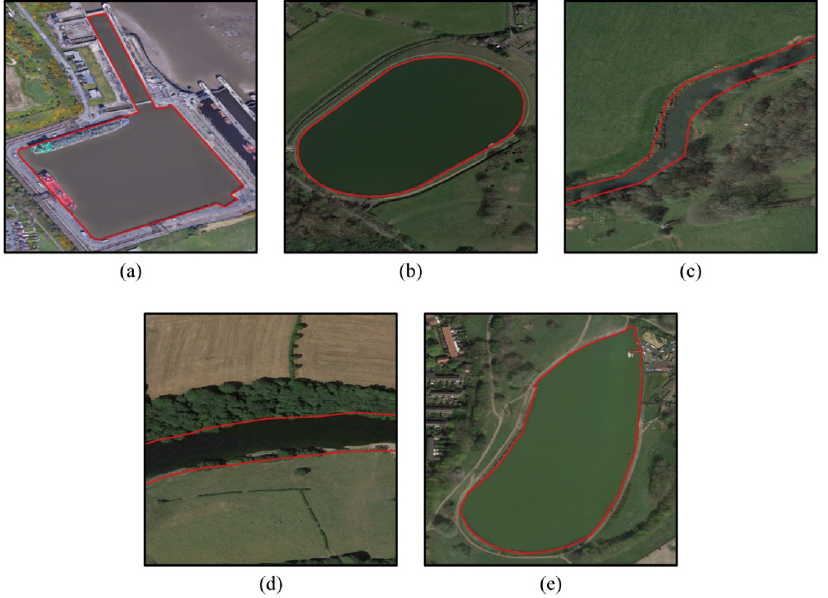
Figure 7. Overlapping Google Earth images with OSM data (highlighted in red) of different types: ( a ) dock; ( b ) reservoir; ( c ) river; ( d ) riverbank; ( e ) water.